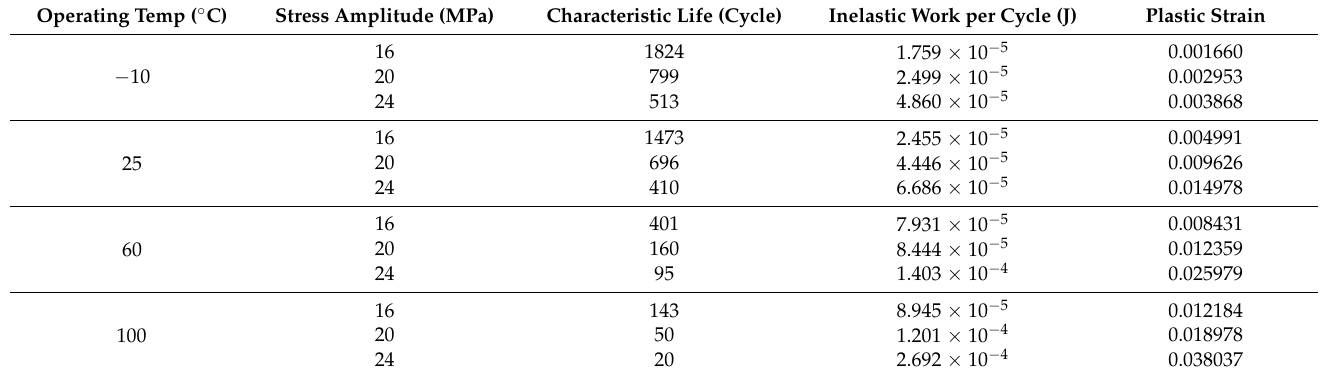
Table 3. Average inelastic work per cycle and plastic strain values.